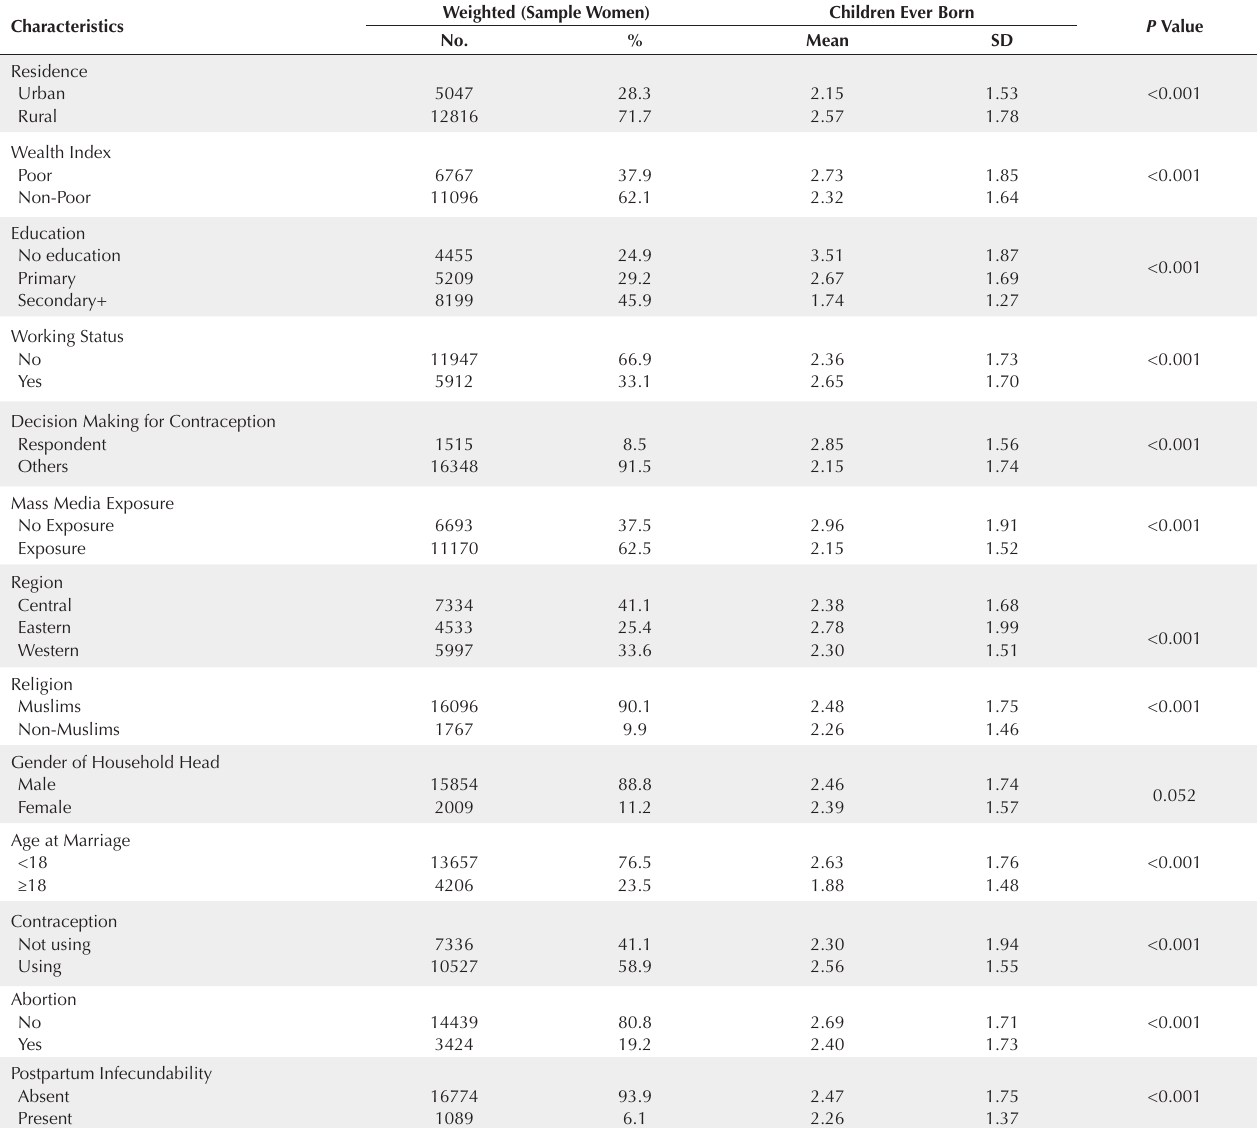
Table 1. Percentage Distribution and Mean Fertility of Ever–Married Women Age 15-49 years by Selected Socio-demographic Characteristics, Bangladesh 2014